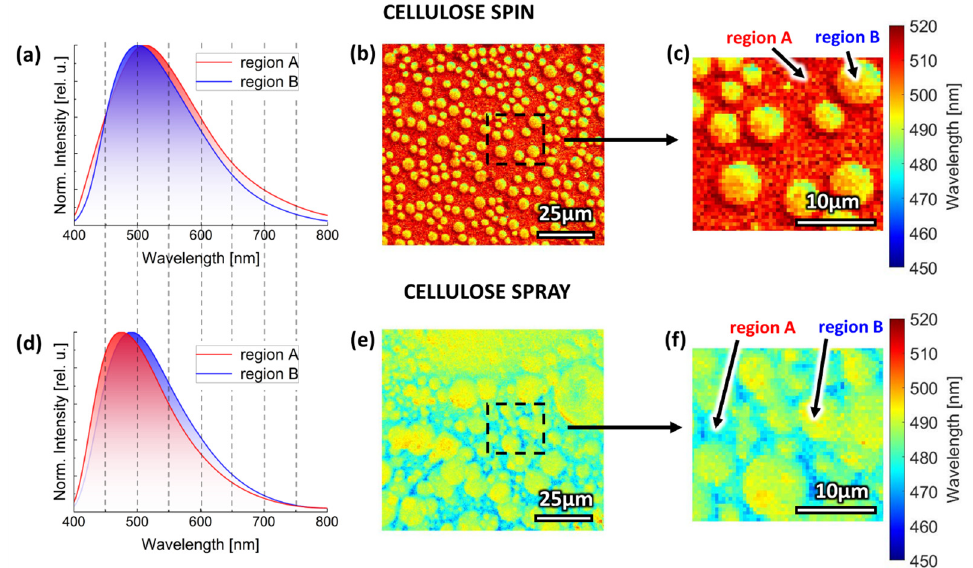
Figure 5. ( a , d ) Normalized PL spectra obtained by averaging an area of 50 × 50 µm 2 of spin- and spray-coated cellulose samples’ surface. ( b , e ) Map of the PL peak wavelength in each point of the image. ( c , f ) Zoom of the dashed areas, respectively shown in panels ( b , e ). Panels ( b , c , e , f ) are plotted with the same color scale.